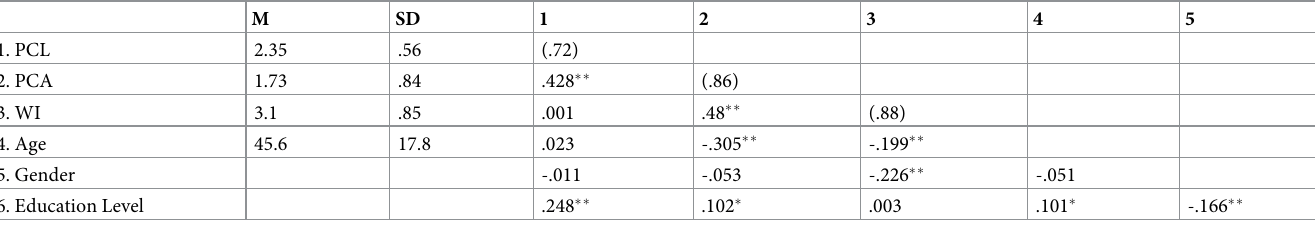
Table 3. Means, standard deviations, bivariate correlations of PCL, PCA, WI, and demographic